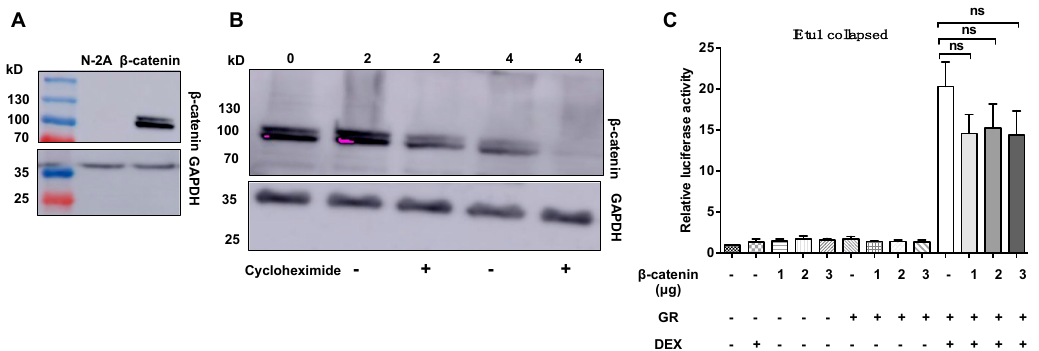
Figure 5. Wt β -catenin is unstable in Neuro-2A cells and does not interfere with GR-mediated transactivation of the IEtu1 promoter. Panel ( A ): Neuro-2A cells were transfected with a plasmid that expresses wt β -catenin (2.0 µ g) or mock-transfected. Twenty-four hours after transfection, WCL was prepared and Western blots were performed using a β -catenin or GAPDH-specific antibody. Each lane contained 10 µ g of protein WCL. Panel ( B ): Neuro-2A cells were transfected with wt β -catenin (2.0 µ g). Twenty-four hours after transfection (denoted as 0), cultures were treated with cycloheximide denoted with a + symbol (100 μ g/mL) for 2 h and 4 h to inhibit protein synthesis. Neuro-2A cells were lysed and processed for Western blot analysis to detect β -catenin or GAPDH. Molecular weight markers and the size of bands are denoted for Panel ( A , B ). Panel ( C ): Neuro-2A cells were transfected with IEtu1 collapsed promoter construct (0.5 μ g), plasmid that expresses GR (1.0 μ g), or wt β -catenin (1.0, 2.0, or 3.0 μ g) and a plasmid expressing Renilla luciferase (0.05 μ g). Empty vector plasmid was added to certain samples to maintain the same amount of DNA in each transfection. Neuro-2A cells were incubated with 2% stripped FBS, and 24 h following transfection, the designated cultures were treated with DEX (10 μ M). At 48 h after transfection, cells were harvested, and protein lysate was subjected to a dual-luciferase assay. The results are the mean from three independent experiments. Statistical analysis was performed with the Student’s T -test: not significant (ns).